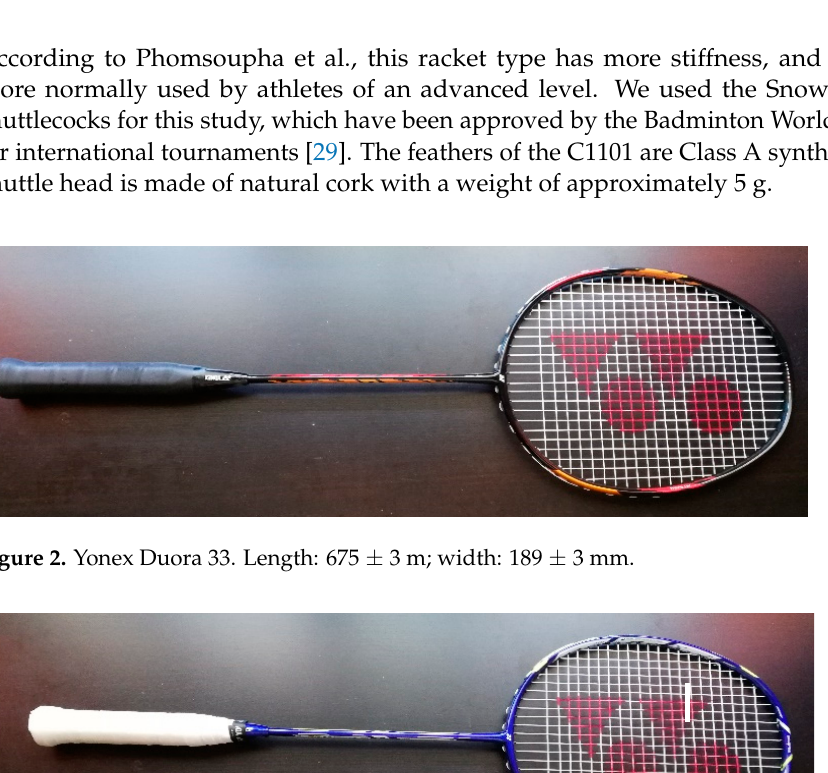
Figure 1. Flow diagram of the experimental procedure.